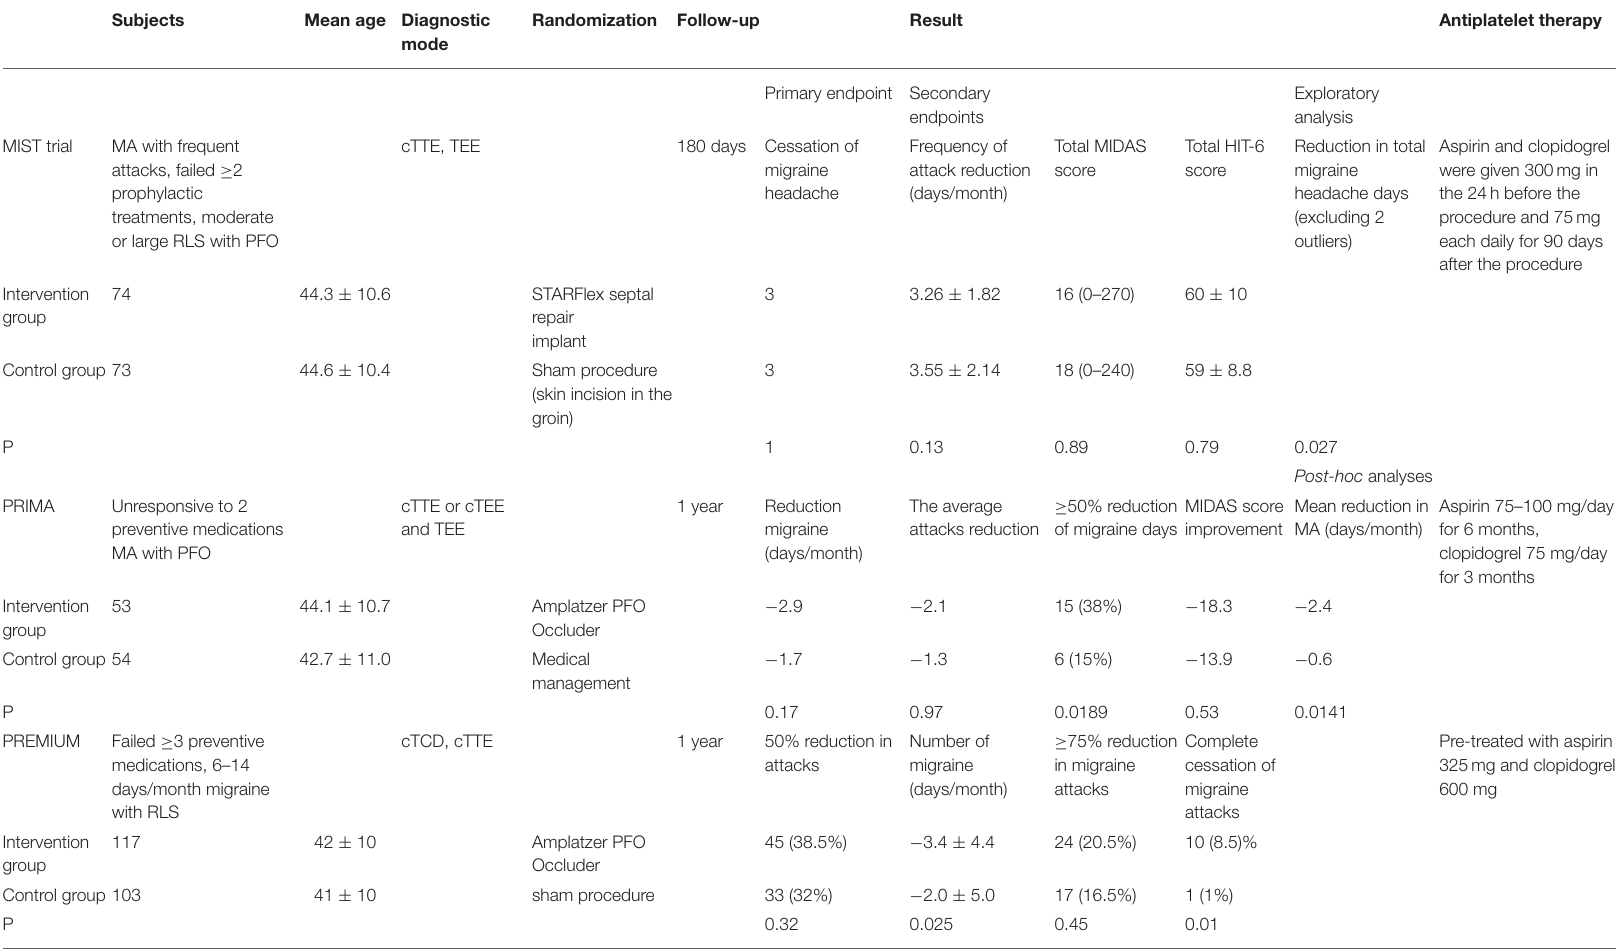
TABLE 3 | The Effect of Patent Foramen Ovale Closure on Migraine in randomized controlled studies. Subjects Mean age Diagnostic